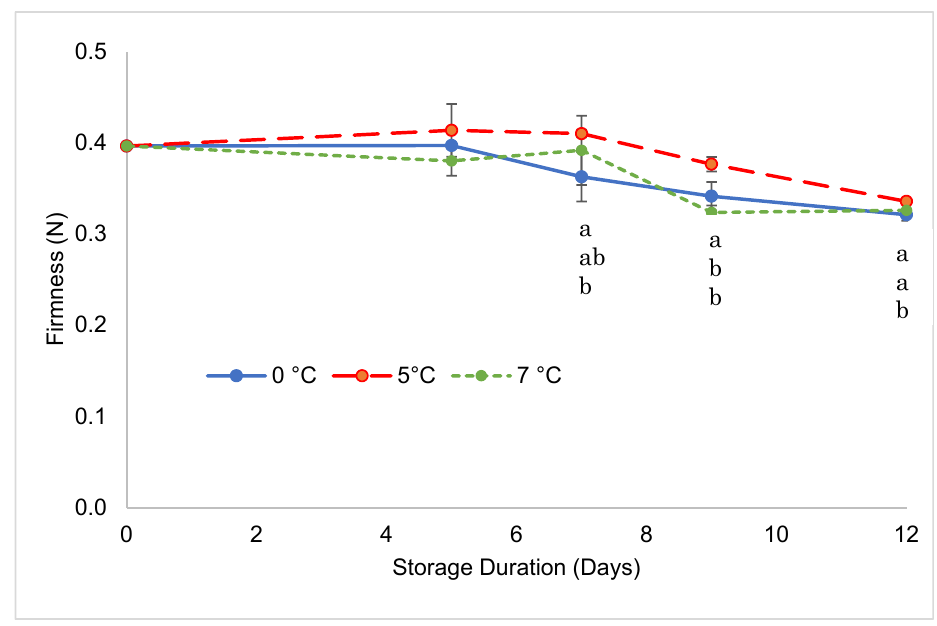
Figure 2. Firmness changes in goji berries during storage at 0, 5, and 7 °C. Values marked with the same letter on the same harvest day are not significantly different, according to a Tukey’s test ( p < 0.05).